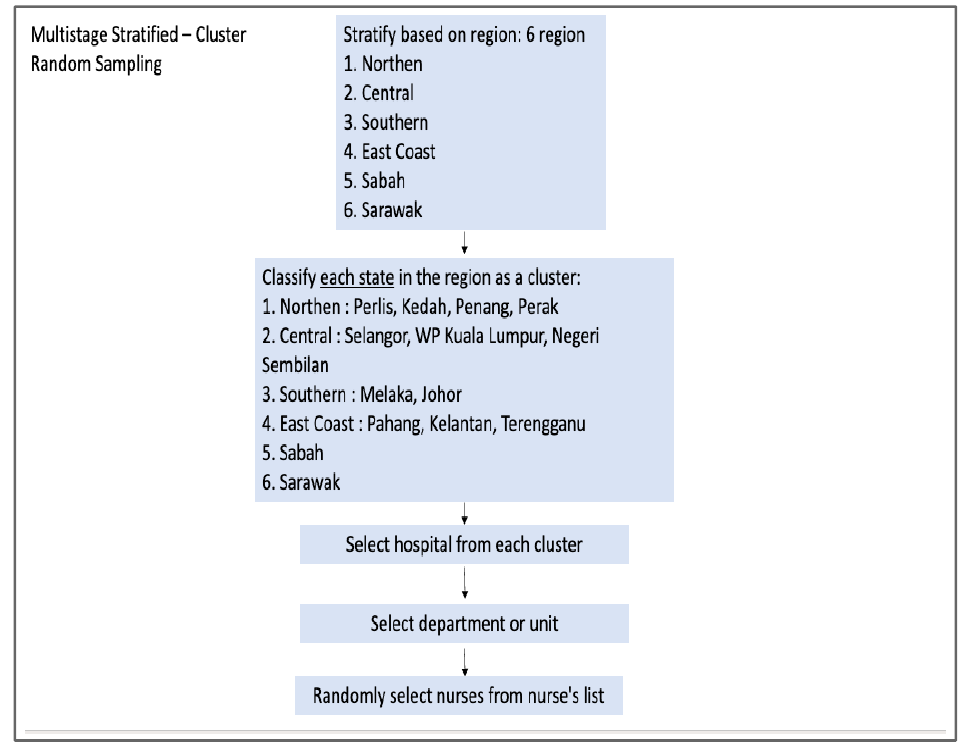
Figure 1. Multistage stratified cluster random sampling for the selection of general hospitals and district hospitals.